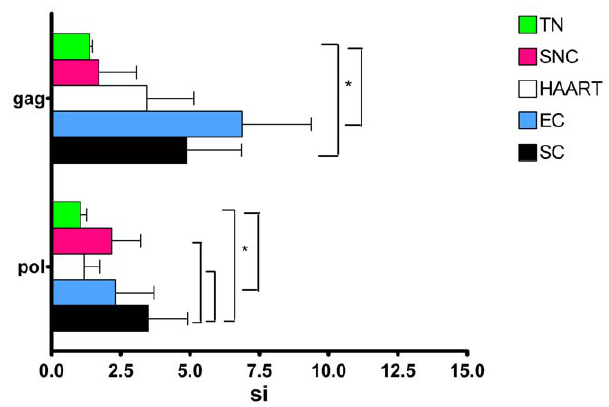
Figure 5. T cell proliferation against Gag and Pol peptides. PBMC from different patient groups were stimulated with Gag peptide pools 1–6 and Pol pools 1–12, spanning the entire Gag-Pol region. The mean stimulation index (SI) + SD for all 4 SC, EC, TN, HAART and SNC is shown. Statistical differences were measured using Mann-Whitney and Kruskall-Wallis test (P , 0.05) and represented in the upper right